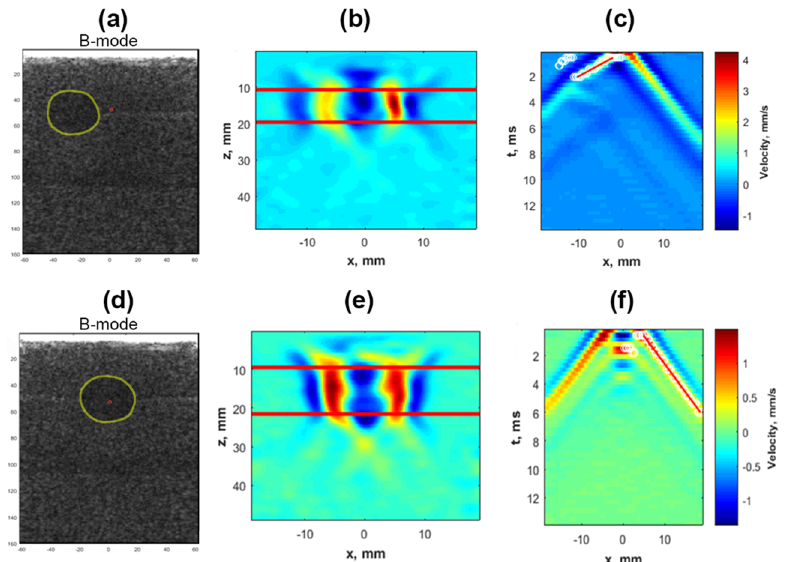
Fig 2. (a) B-mode image of a type IV inclusion (yellow circle) along with push beam location (red dot). (b) Particle velocity maps showing right and attenuated left wing of the shear wave. (c) Spatio-temporal map for the region selected by two horizontal red lines, the estimated group velocity for left shear wave is 5.59 m/s. (d) B-mode image of type IV inclusion along with push beam focused inside the inclusion. (e) Particle velocity map with similar looking left and right wings of shear wave. (f) Spatio-temporal map with estimated group velocity for right shear wave as 2.53 m/s, which corresponds to background material.